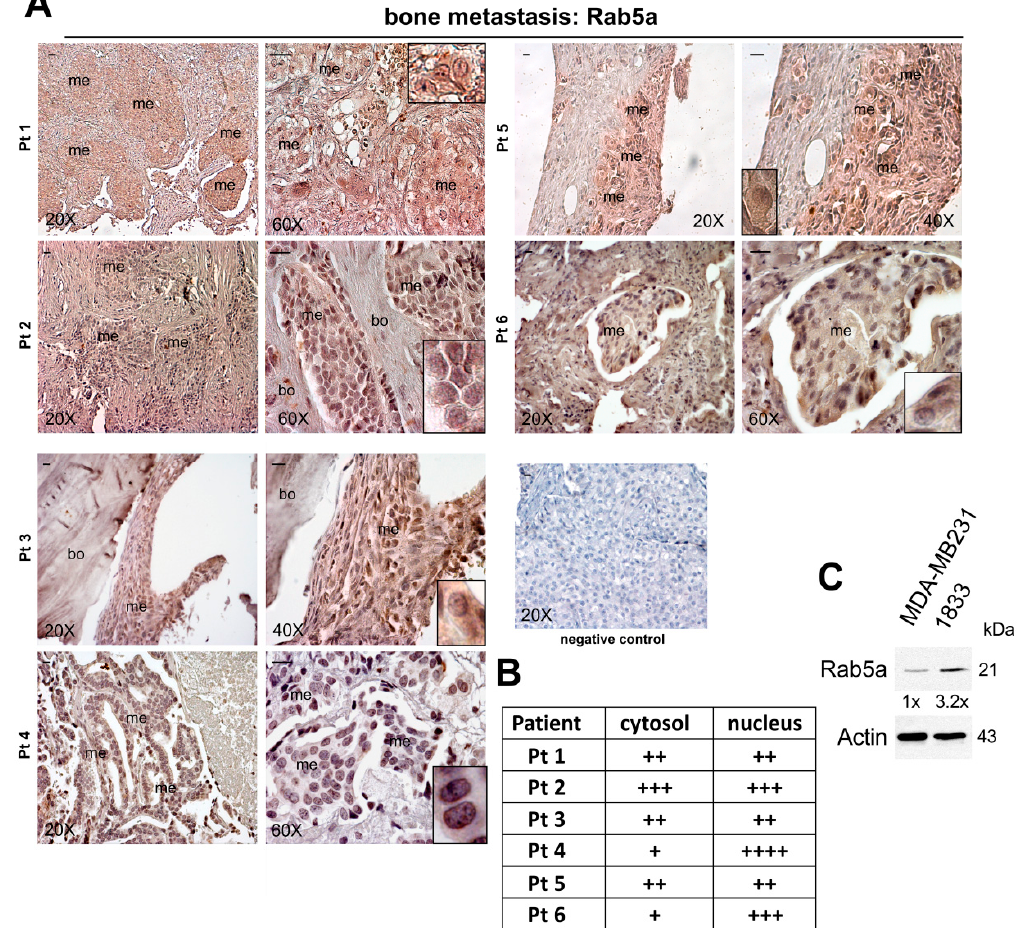
Figure 2. Rab5a expression in human bone metastasis from breast carcinoma. ( A ) For Pts 1–6, we show representative images of immunohistochemical staining for Rab5a in bone metastases pair matched with primary carcinoma. Magnification of details is shown. Bar = 240 µm. Negative control was assayed without the specific antibody. We analysed by immunohistochemistry five serial sections prepared from each human specimen. me, bone metastasis; bo, bone; ( B ) For the six Patients, we performed a semi-quantitative evaluation of Rab5a intracellular distribution; the evaluation was performed on the five serial sections for each specimen analysed by immunohistochemistry; ( C ) Samples of total protein extracts (100 µg) were used for Western blot analysis of Rab5a. Actin was used for normalization. The experiments were repeated three times with similar results.